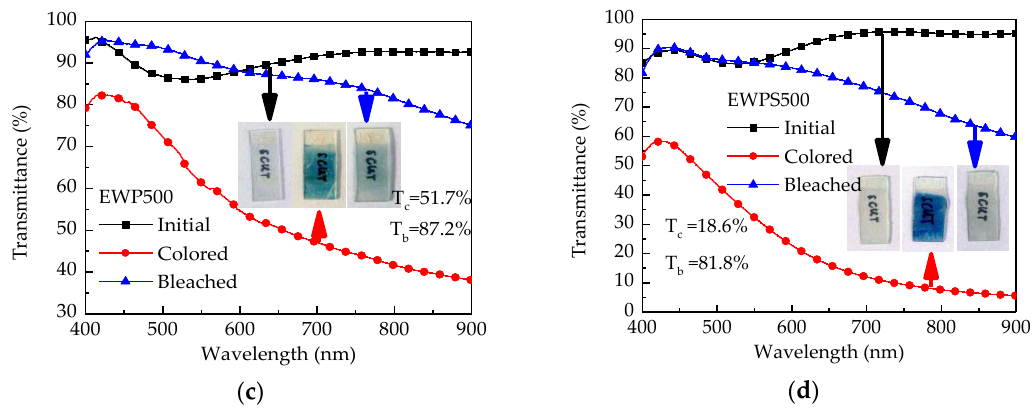
Figure 9. The transmittance and images of different WO 3 films at the initial state, colored state, and bleached state: ( a ) EW500, ( b ) EWS500, ( c ) EWP500, ( d ) EWPS500. T c and T b are the transmittance of the colored state and bleached state at wavelength 628 nm, respectively.